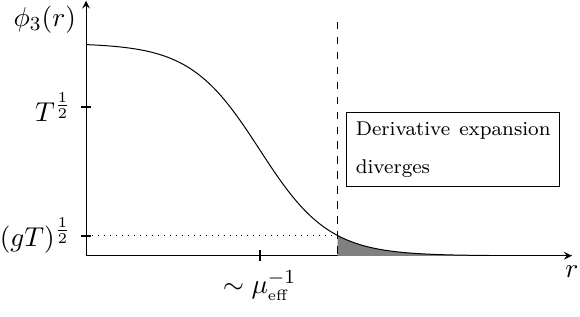
Figure 1 . Schematic bubble profile with a thick-wall. At the (shaded) tail of the profile, the derivative expansion diverges but the scaling φ 2 3 scale effective action from this